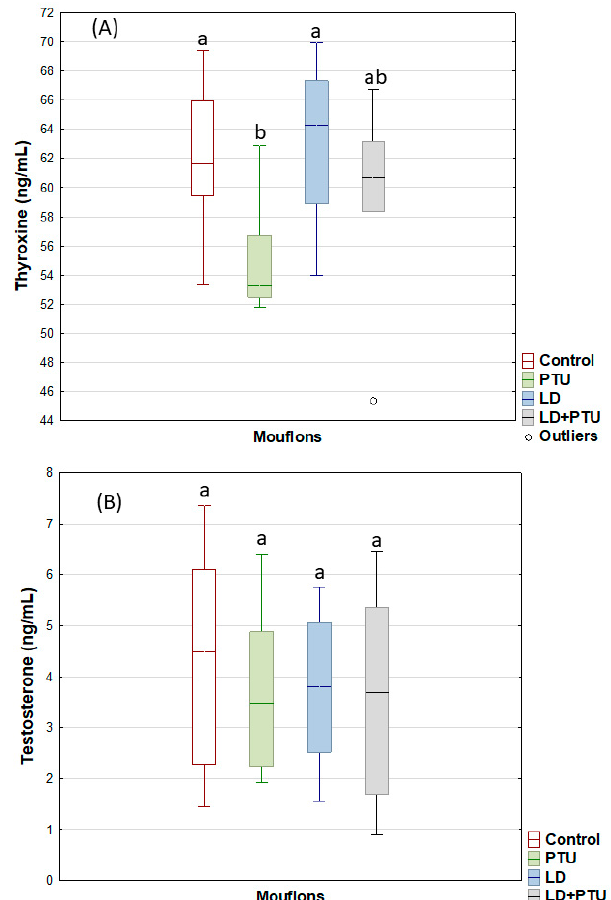
Figure 7. Plasma thyroxine ( A ) and testosterone ( B ) concentrations in mouflons: controls (red), administered propylthiouracil (PTU, green), exposed to long day photoperiod (LD, blue), exposed to long day photoperiod plus administration of PTU (LD+PTU, gray). The boxes spread form the 1st to the 3rd quartiles. Box plots show the median (horizontal line) and spread from the 1st to the 3rd quartiles; the whiskers extend from the smallest to the largest value. Outliers are shown as circles. Different letters (a,b) between boxplots indicate significant differences ( p < 0.001). Table 2. Mouflon fresh sperm variables and cryoresistance ratio (CR) for the control, PTU (treated with propylthiouracil), LD (artificial long day photoperiod) and LD+PTU (artificial long day photoperiod plus PTU) groups. Different letters indicate significant differences ( p < 0.05).